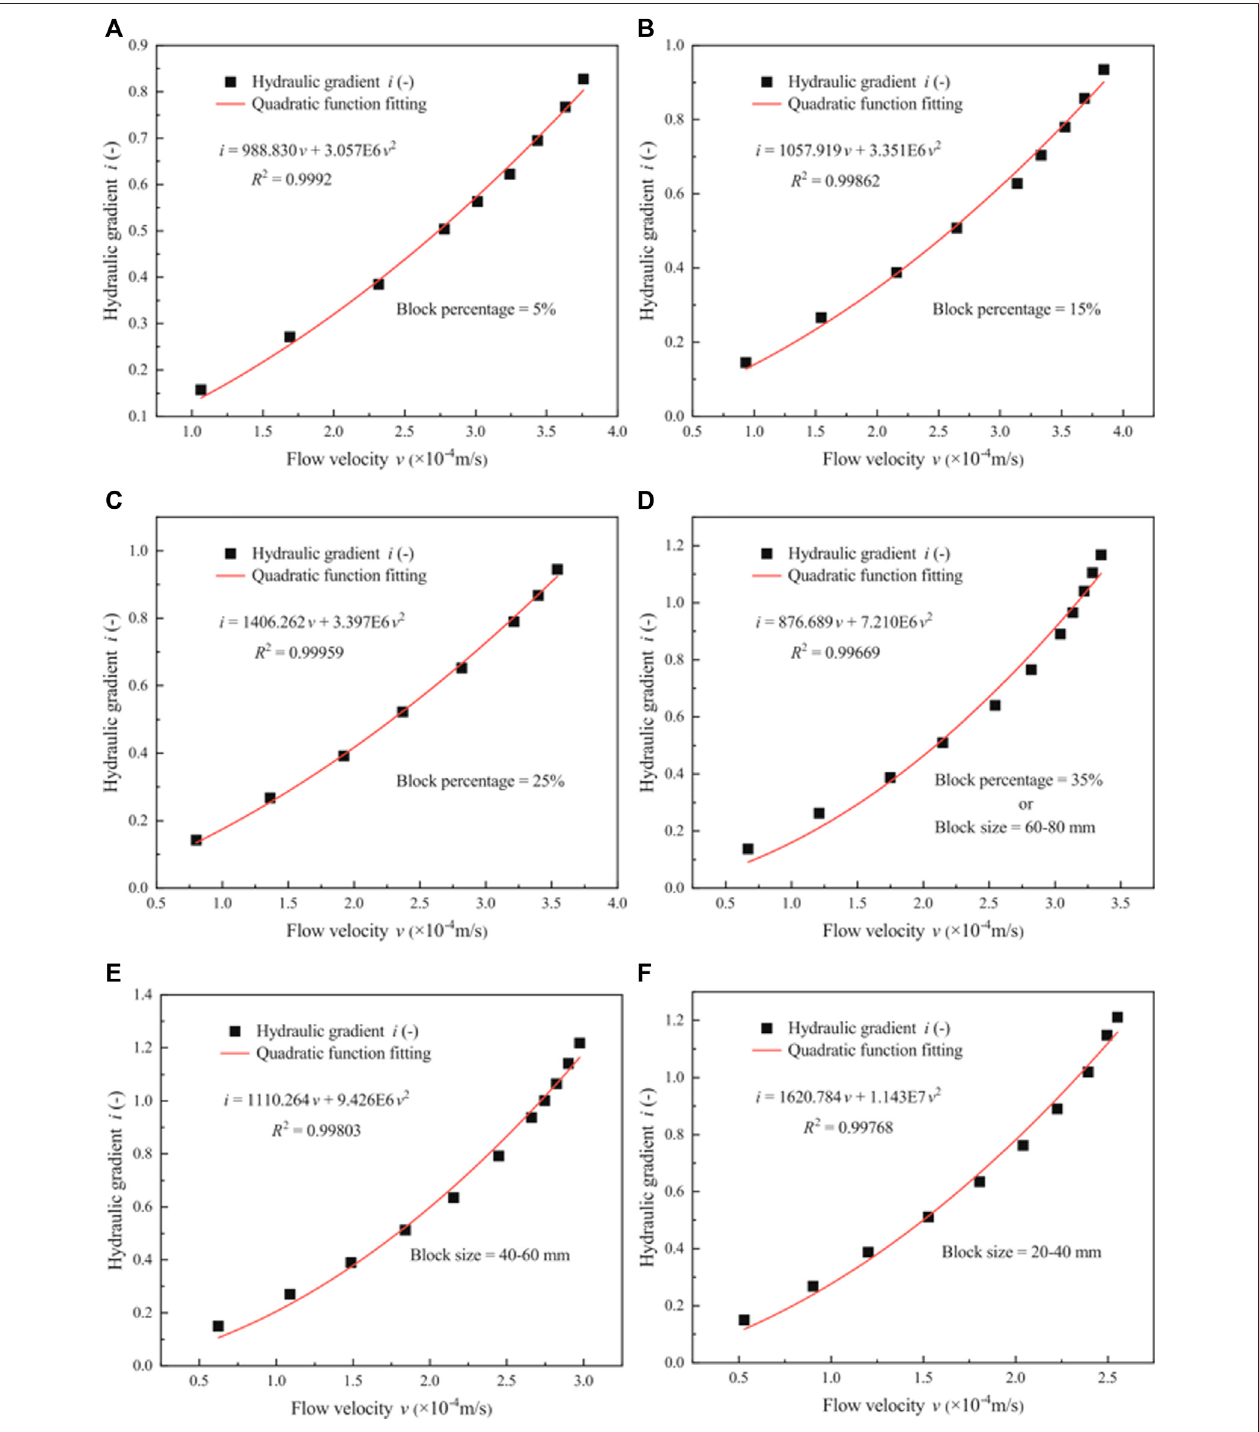
FIGURE 9 | Relationship between the hydraulic gradient and the fl ow velocity by Forchheimer equation. (A – D) Plots for phyllite bimrocks with different block percentages of 5%, 15%, 25%, and 35%, respectively; (D – F) Plots for phyllite bimrocks with different block sizes of 60 – 80, 40 – 60, and 20 – 40 mm, respectively.